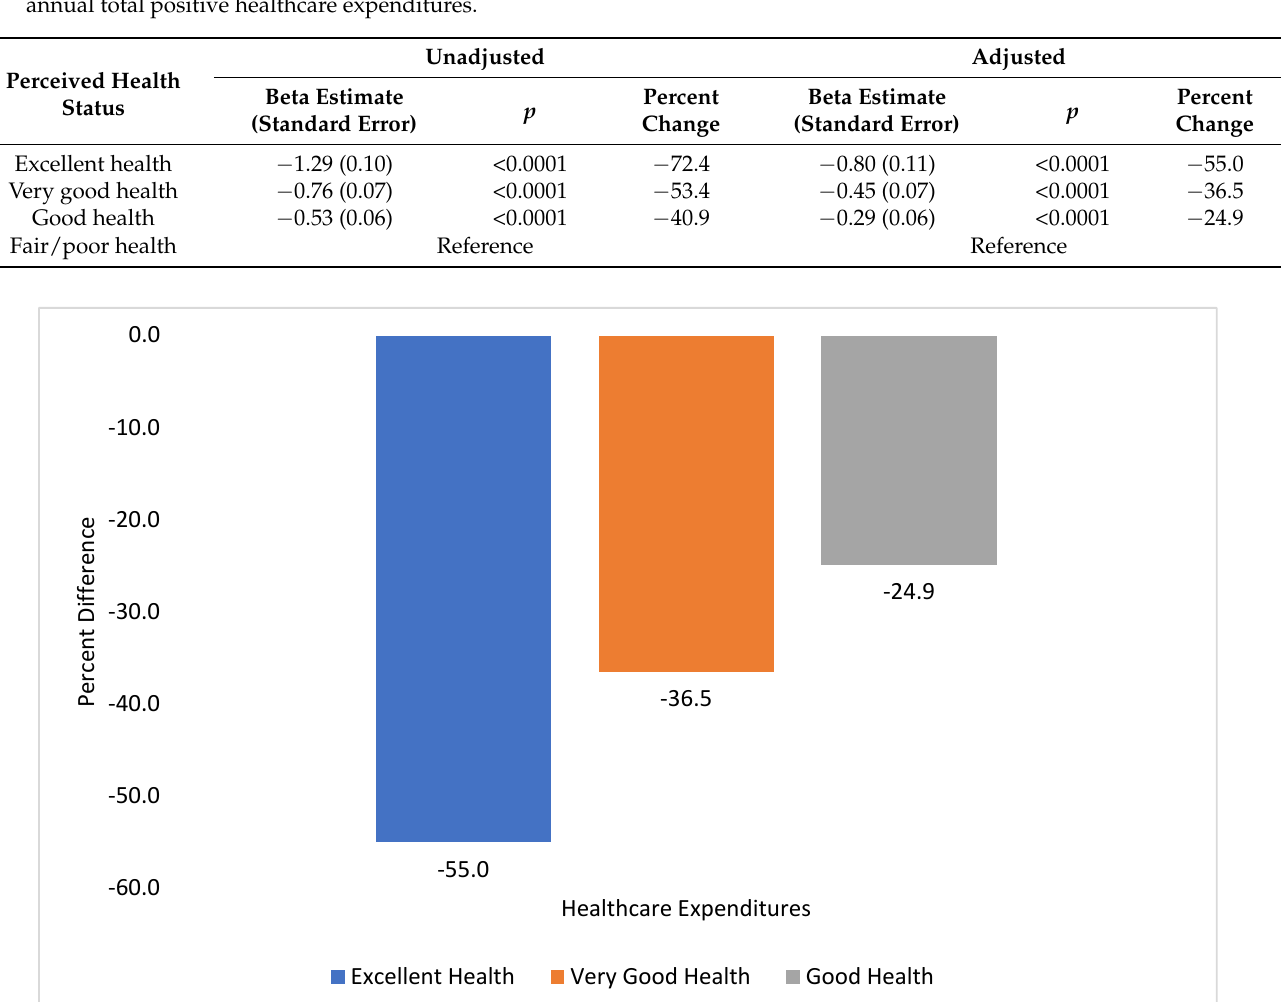
Figure 1. Percent difference in 2018 adjusted annual total positive healthcare expenditures for United States older adults (age ≥ 50 years) with self ‐ reported pain in the past four weeks. Percent change represents the difference in adjusted 2018 healthcare expenditures between United States older adults with self ‐ reported pain with fair/poor health (reference group) and excellent health (blue bars), very good health (orange bars), and good health (grey bars).